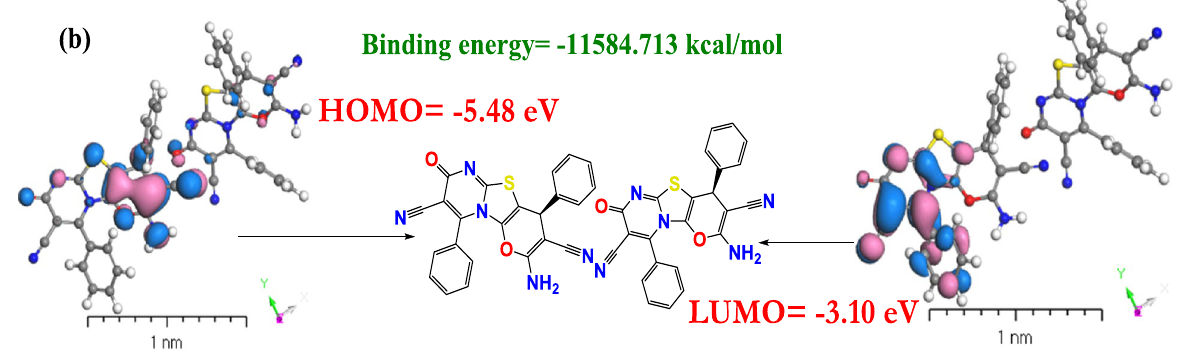
Figure 5. DFT computations using DMOl 3 method for HOMO and LUMO calculations of ( a ) the isolated molecule and ( b ) the dimer.